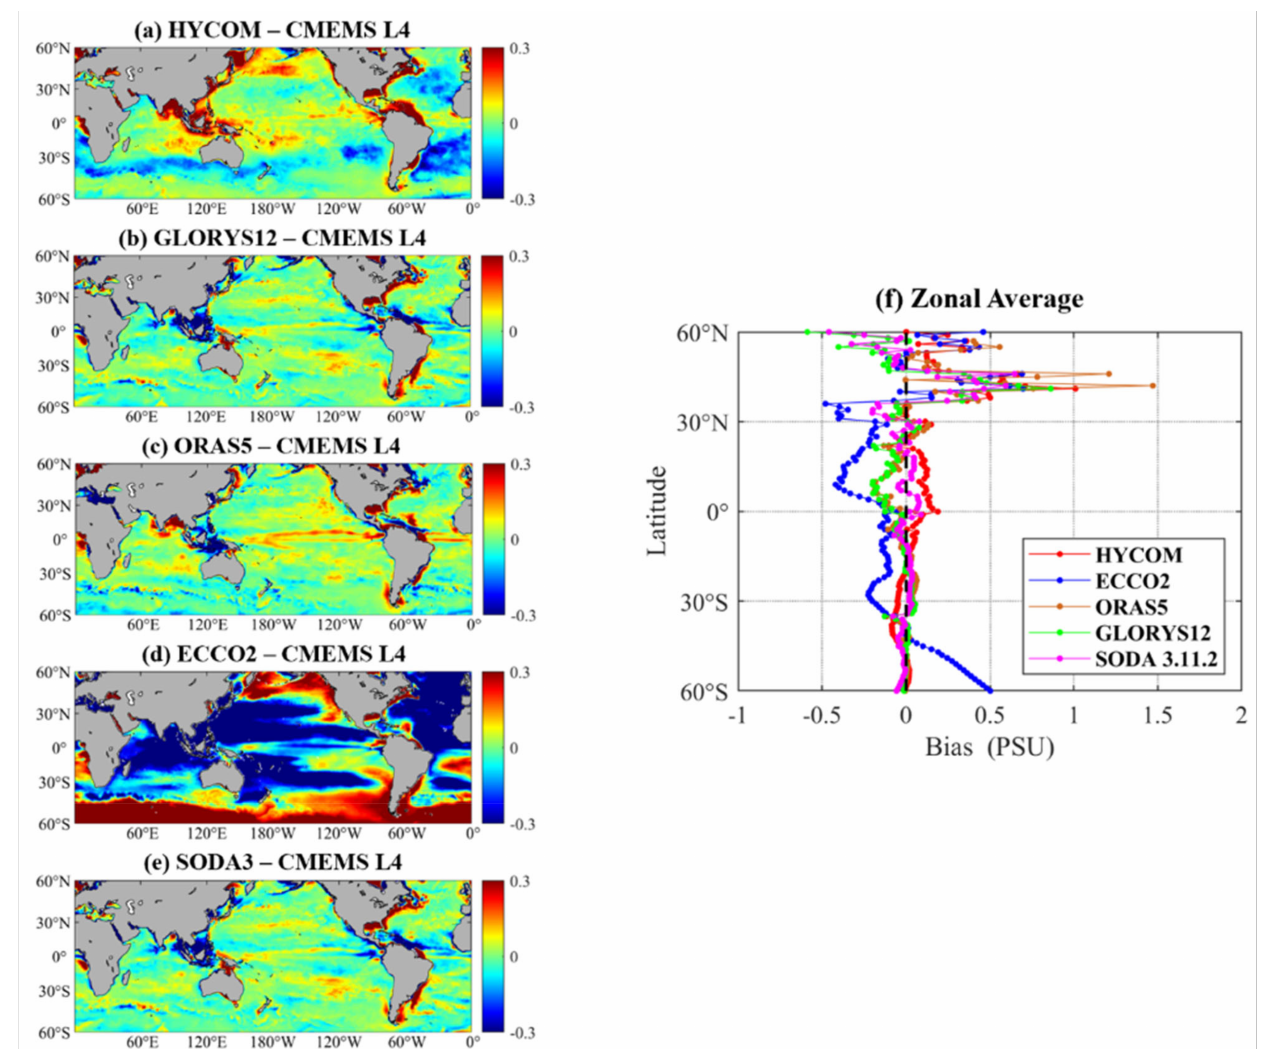
Figure 7. Comparison of ∆ SSS in five reanalysis SSS against the CMEMS L4 SSS product, including ( a ) HYCOM, ( b ) GLORYS12, ( c ) ORAS5, ( d ) ECCO2 and ( e ) SODA3. ( f ) The zonal average of ∆ SSS values from 60 ◦ N to 60 ◦ S. The unit is in